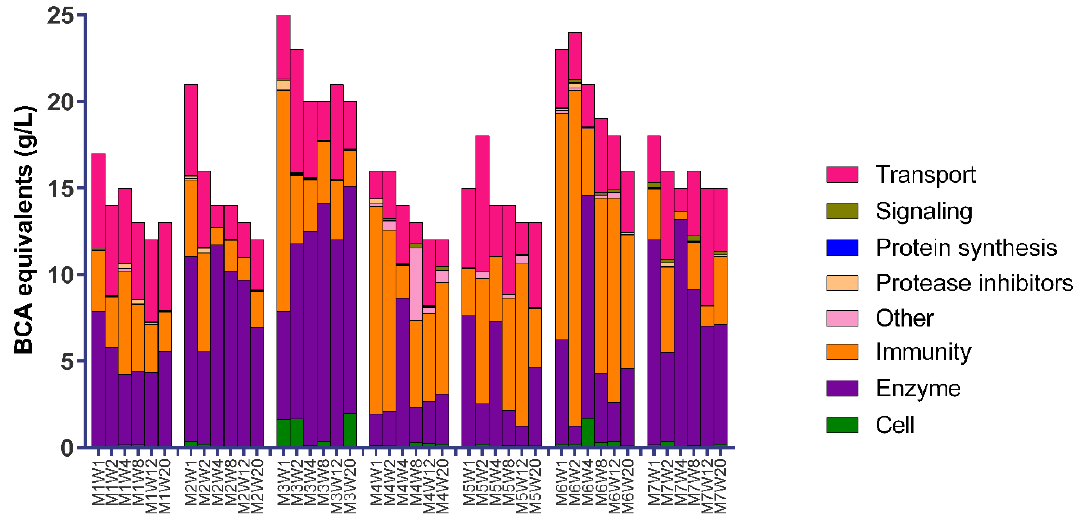
Figure 2. Serum protein composition in human milk of seven Chinese mothers over a 20-week lactation period, based on BCA equivalent values (g/L). The number after the M indicates the mother, and the numbers after the W (1 to 20) indicates the number of weeks postpartum.